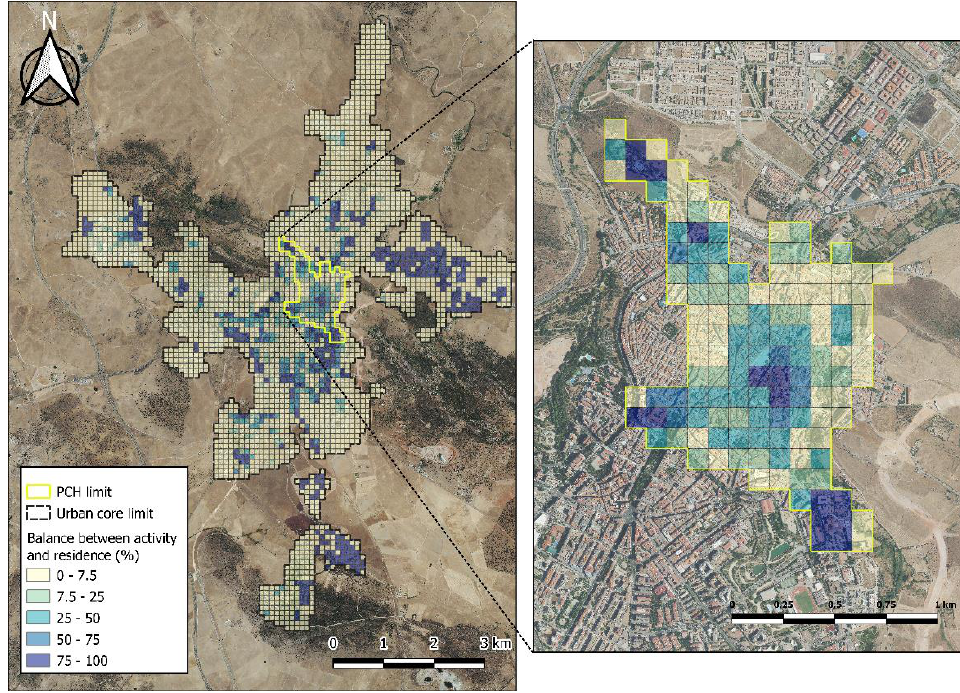
Figure 14. Balance between activity and residency comparison.